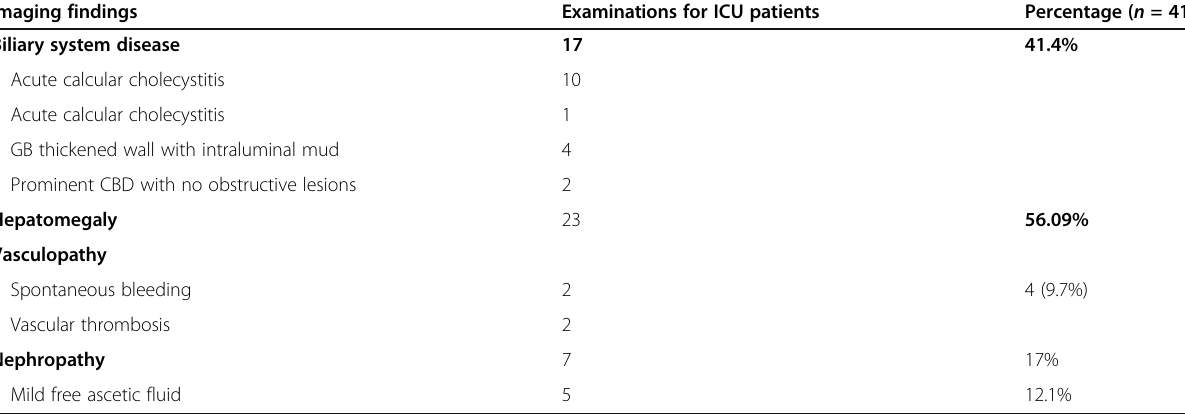
Table 3 Sonographic imaging findings in the studied patient sample (NB: more than one finding in one examination was noted) Imaging